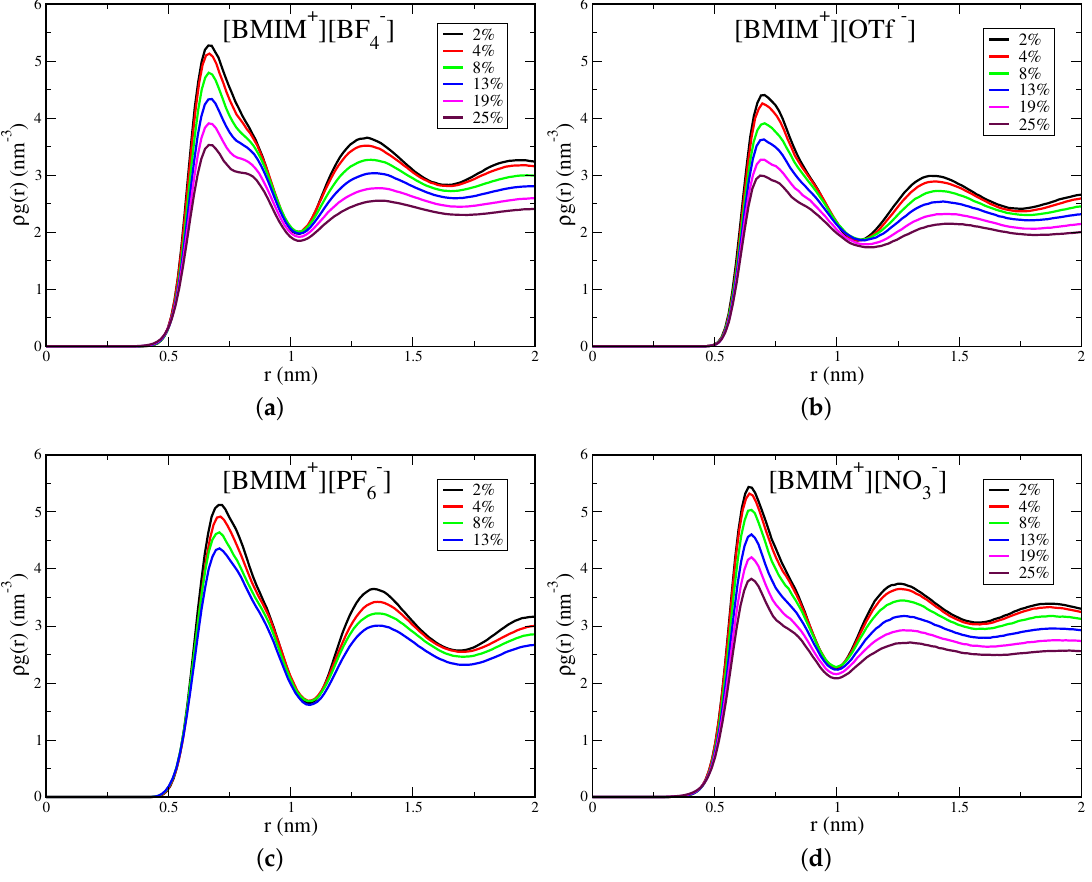
Figure 7. Anion-anion pairwise distributions computed from anion center of mass for ( a ) [BMIM + ][BF − ], ( b ) [BMIM + ][OTf − ], ( c ) [BMIM + ][PF − 4 Distributions are normalized by the density of